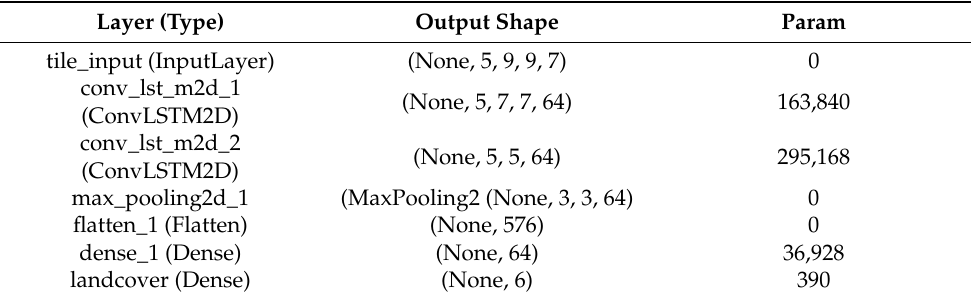
Table 3. Architecture for recurrent convolutional neural network as output as printed from the model.summary method in keras showing the layer name, the shape of that tensor, and the number of trainable parameters in each layer. The tile_input layer shows the input of 5 time steps, by 9 pixels, by 9 pixels, by 7 image bands. This input is put through two Conv2DLSTM layers, followed by a 3 × 3 max pooling. The output from the max pooling layers is flattened, run through a dense layer, and output into the six final